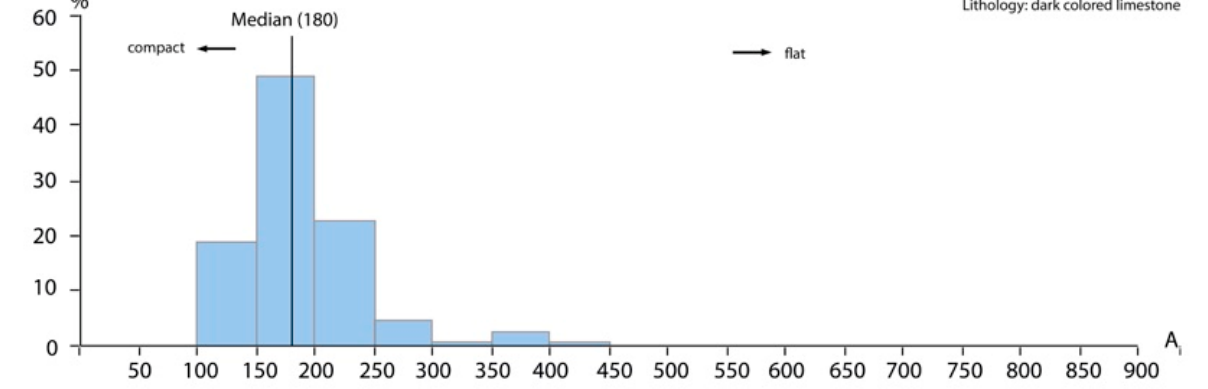
Table 2. Cosmogenic 10 Be and 26 Al results of the samples from the Möhlin site.